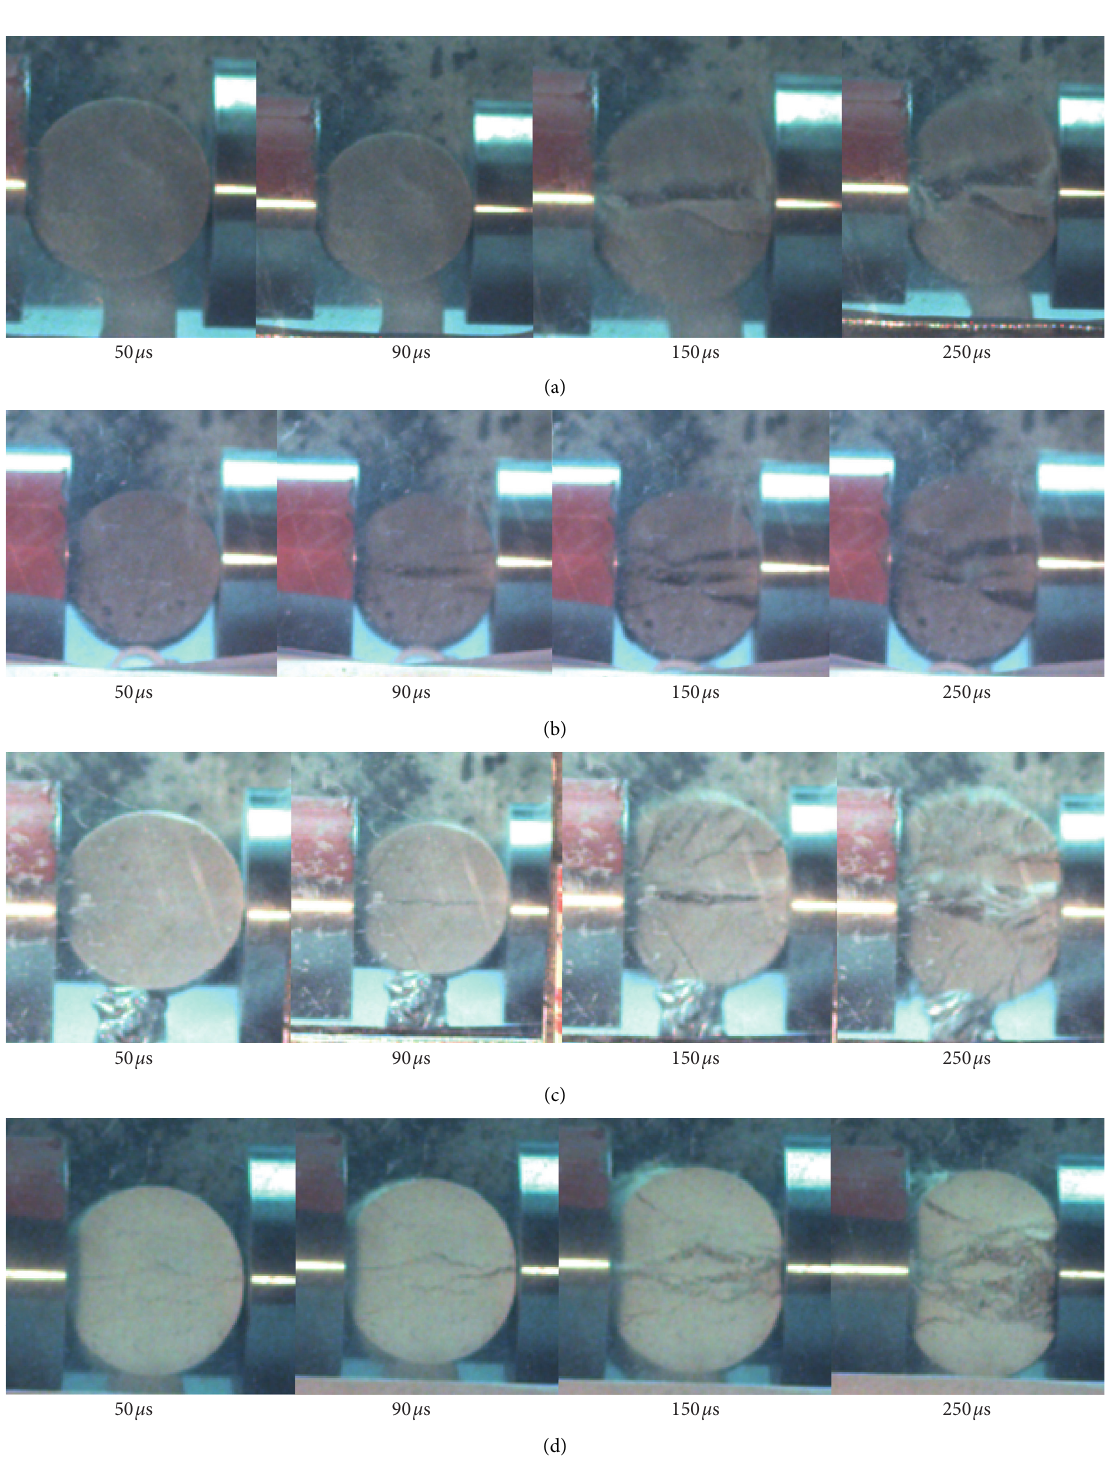
Figure 19: Failure process of marble under temperature from 200 ° C to 800 ° C obtained by a high-speed camera. (a) 200 ° C. (b) 400 ° C. (c) 600 ° C. (d) 800 °